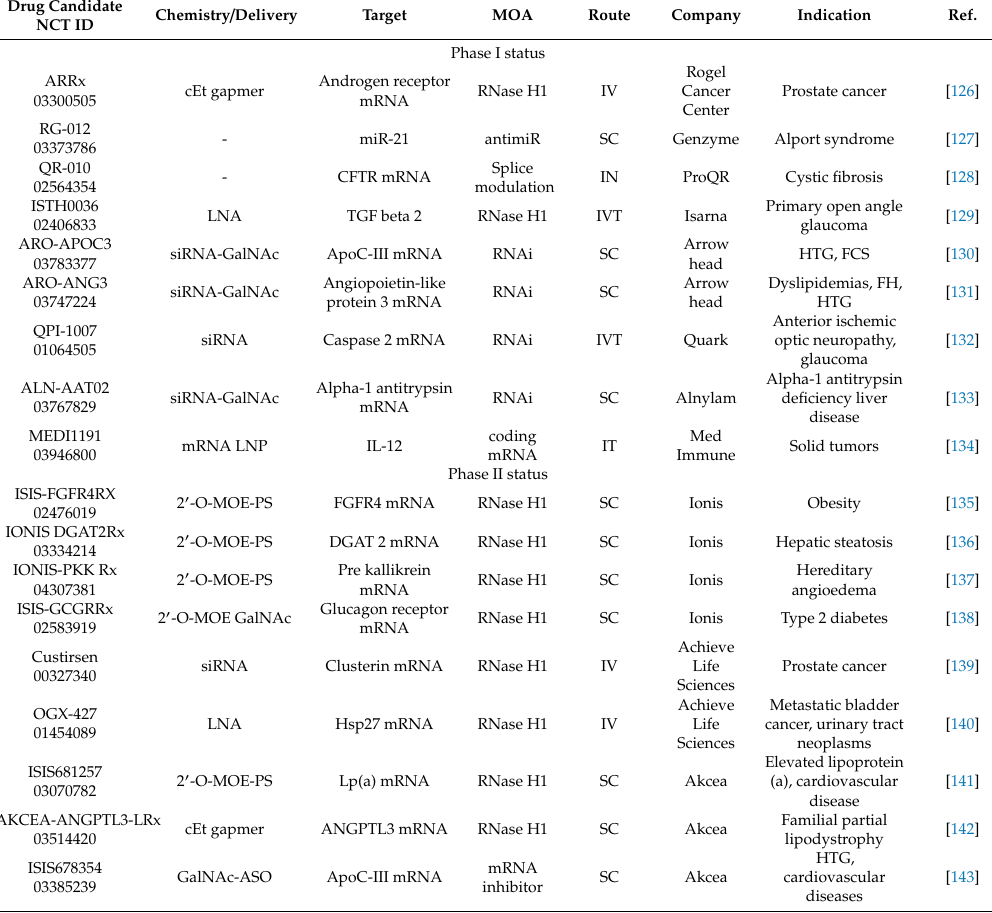
Table 3. Potential drug candidates in clinical